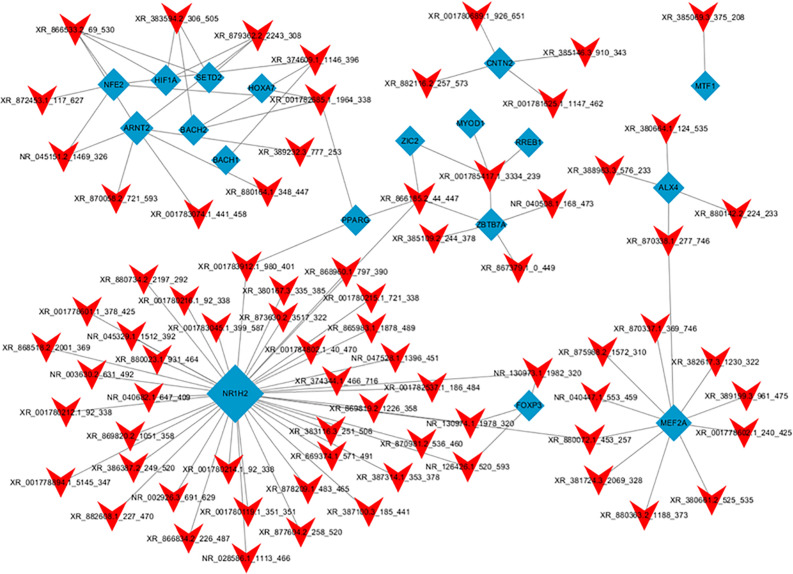
Network of the top 100 most related lncRNA-transcription factor pairs. The co-expression networks of the lncRNA and transcription factor were constructed using Cytoscape software (version 3.5.1). Red arrowheads, lncRNAs; blue diamonds, transcription factors.